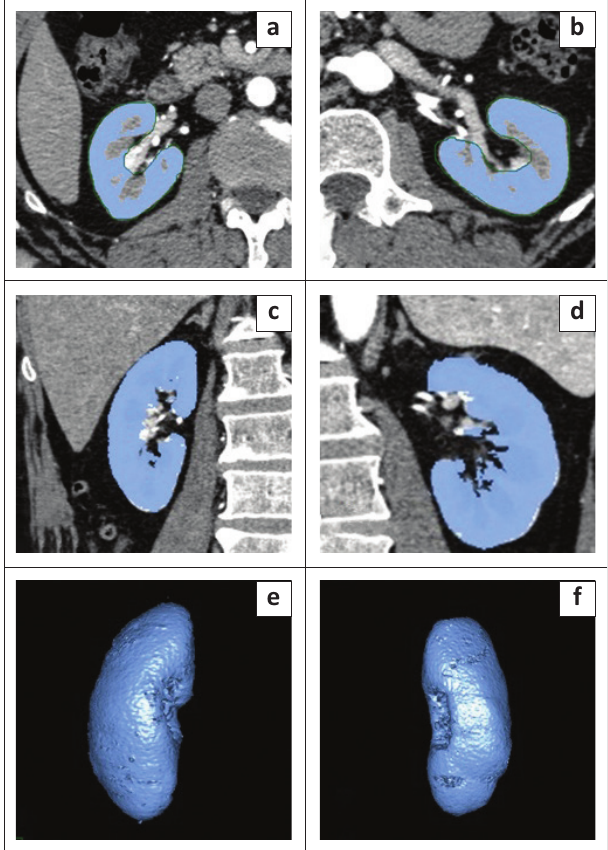
FIGURE 1 : The process of measuring kidney volume. The semiautomatic region of interest tool was applied slice by slice on axial arterial phase images (a) and (b), as well as on coronal arterial phase images (c) and (d). The semiautomated software estimated the kidney volume (e) and